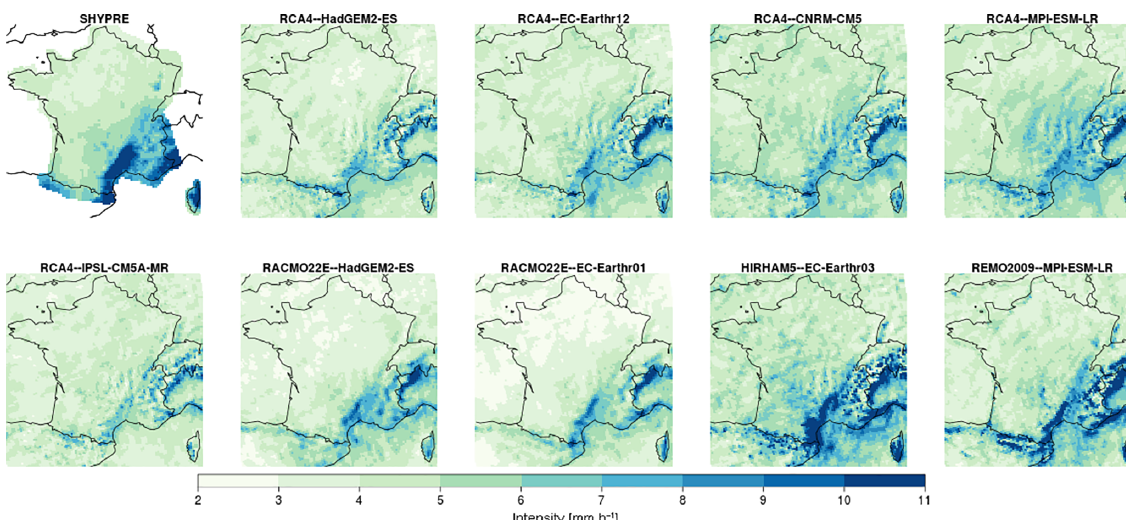
Figure 5. Intensity for 10-year return period for 12h duration of SHYPRE and all models in the RCM ensemble for France.